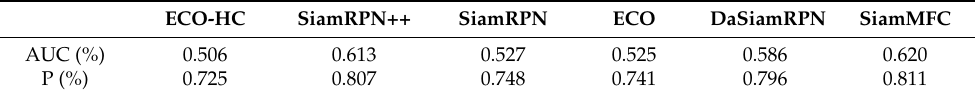
Table 1. Comparison results on UAV-123